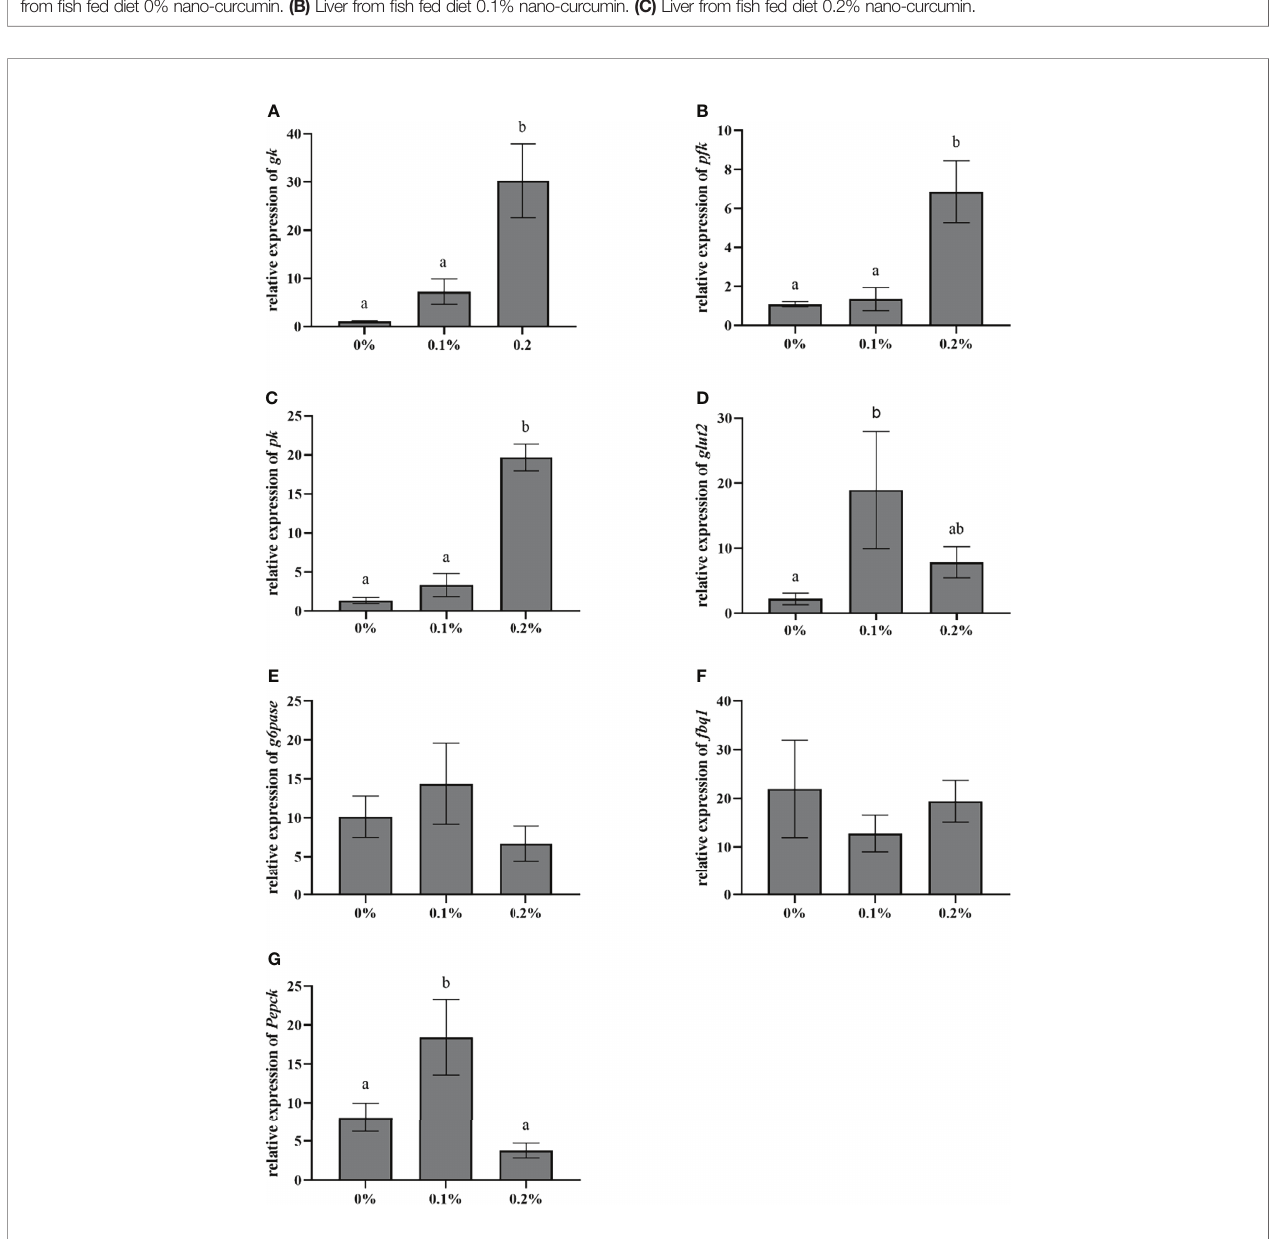
FIGURE 4 | Effect of dietary nano-curcumin on glucose transporter 2 ( glut2 ) (A) , glucokinase ( gk ) (B) , phosphofructokinase liver type ( pfk ) (C) , pyruvate kinase ( pk ) (D) , glucose-6- phosphatase catalytic subunit ( G6pase ) (E) , fructose-bisphosphatase1 ( fbp1 ) (F) , and phosphoenolpyruvate carboxykinase ( Pepck ) (G) related gene mRNA levels in the liver of largemouth bass. Values (mean ± standard error of the mean, SEM) in bars that have the same letter are not signi fi cantly different (P > 0.05; Duncan ’ s test) between treatments (N =